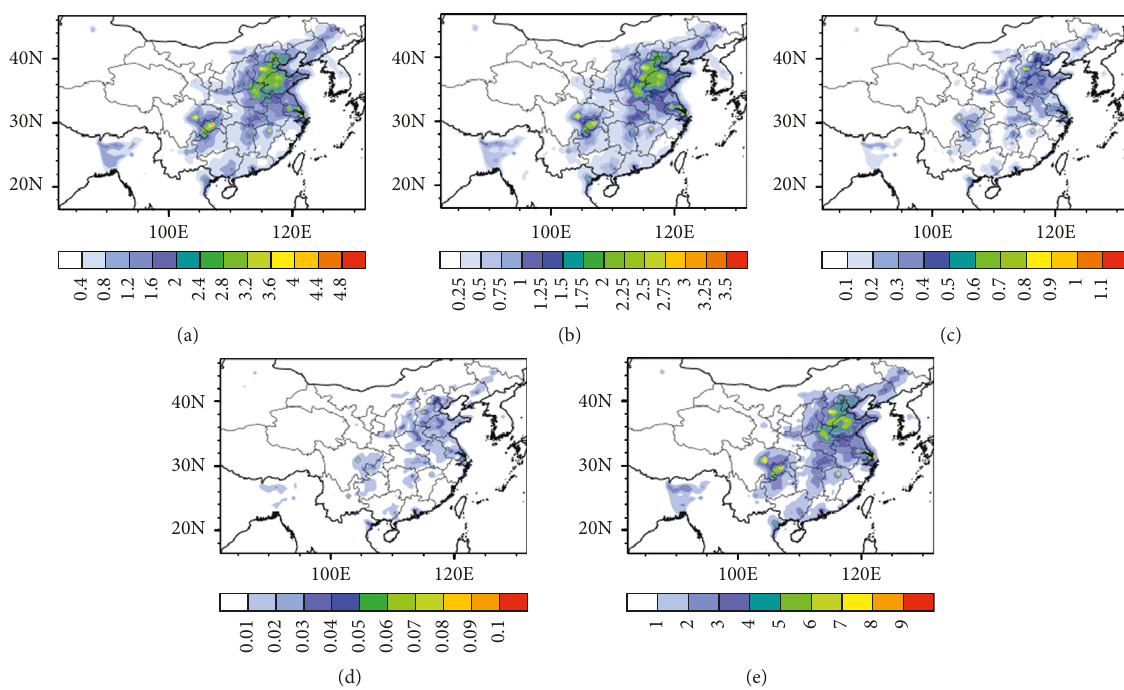
Figure 5: Distributions of the different modes and the total ground surface concentrations of BC aerosols ( μ g/m 3 ). (a) BC1. (b) BC2. (c) BC3. (d) BC4. (e) BC